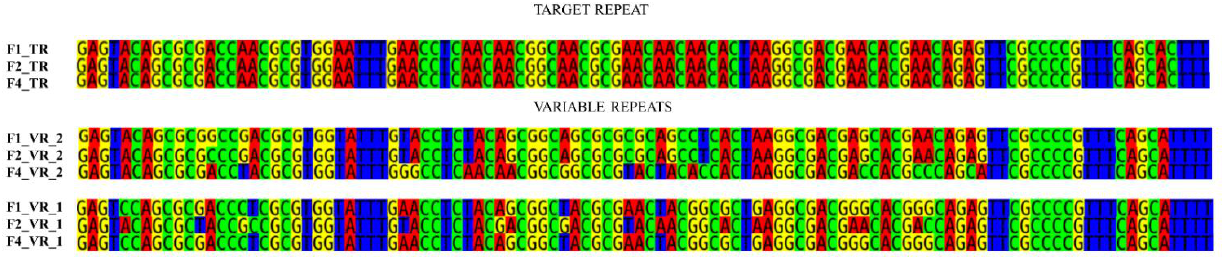
Figure 3. Alignment of the TRs and VRs from isolated Bacuni phages. VR2, located in the close proximity of reverse transcriptase gene, possesses three quarters of all SNP sites differentiating bacteriophages F1 and F4, which infect different hosts.